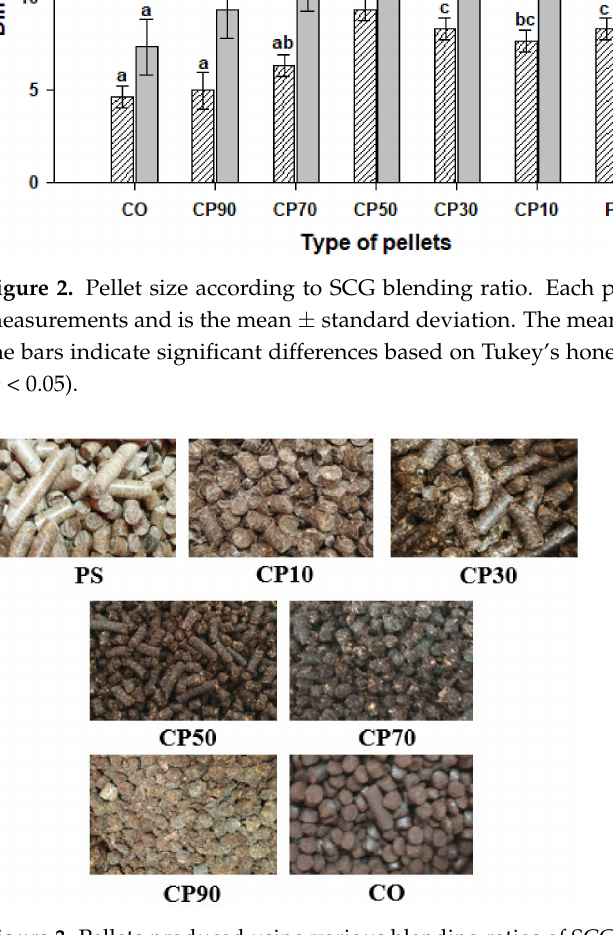
Figure 3. Pellets produced using various blending ratios of SCG and pine sawdust